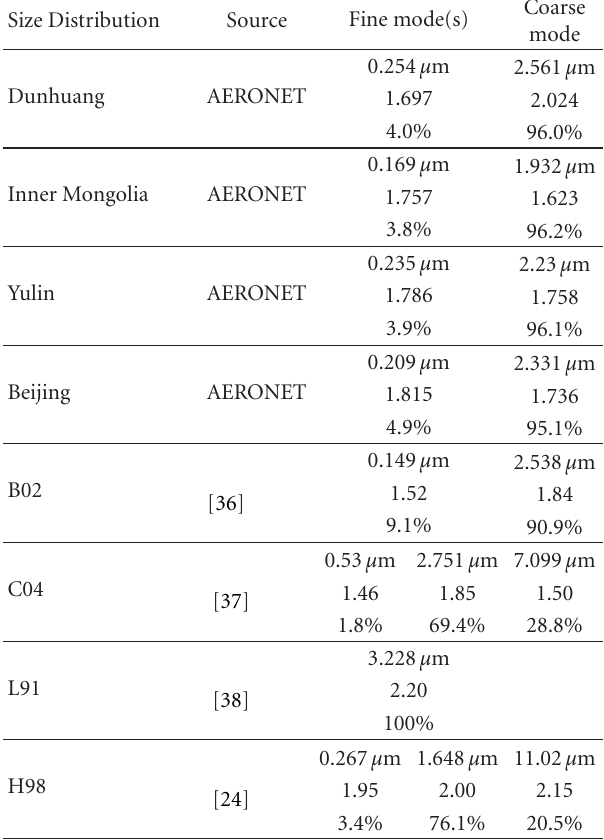
Table 1: Parameters of dust volume size distributions from AERONET sites in East Asia (Dunhuang, Inner Mongolia, Yulin, and Beijing) and past studies. The lognormal parameters shown are volume median radius ( μ m), geometric standard deviation, and mass fraction